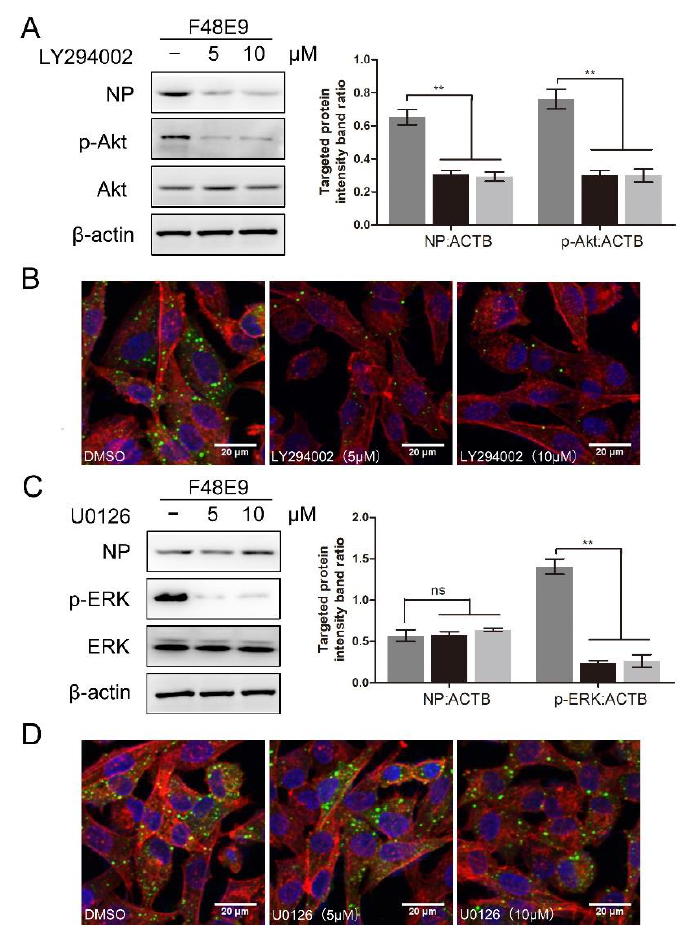
Figure 8. The effect of inhibition of PI3K/Akt or ERK pathway on NDV entry. ( A , B ) DF-1 cells were infected with F48E9 (MOI = 5) at 4 °C for 1 h. Unbound viruses were washed away by pre-chilled PBS. Next, cells were supplemented with different medium-containing LY294002. At 4 h post-infection, the viral protein was measured by Western blot ( A : left panel). The targeted protein levels relative to ACTB levels were determined by densitometry ( A : right panel). The entry of virus was measured by indirect immunofluorescence ( B ). ( C , D ) DF-1 cells were infected with F48E9 (MOI = 5) at 4 °C for 1 h. Unbound viruses were washed away by pre-chilled PBS. Next, cells were supplemented with different medium-containing U0126. At 4 h post-infection, the viral protein was measured by Western blot ( C : left panel). The targeted protein levels relative to ACTB levels were determined by densitometry ( C : right panel). The entry of virus was measured by indirect immu- nofluorescence ( D ). The statistical significance was analyzed using a two-tailed Student ’s t -test: ns (not significant); ** p < 0.01.